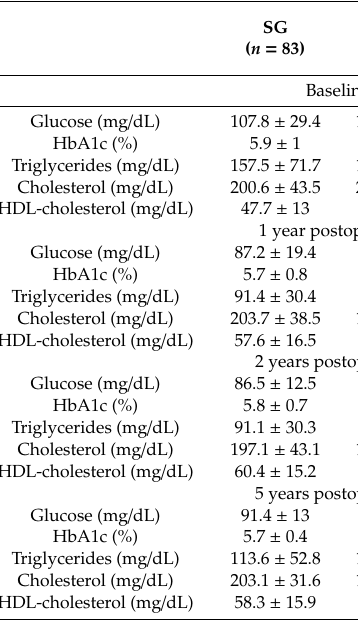
Table 6. Glycemic and lipid profile at 1, 2 and 5 years after surgery.